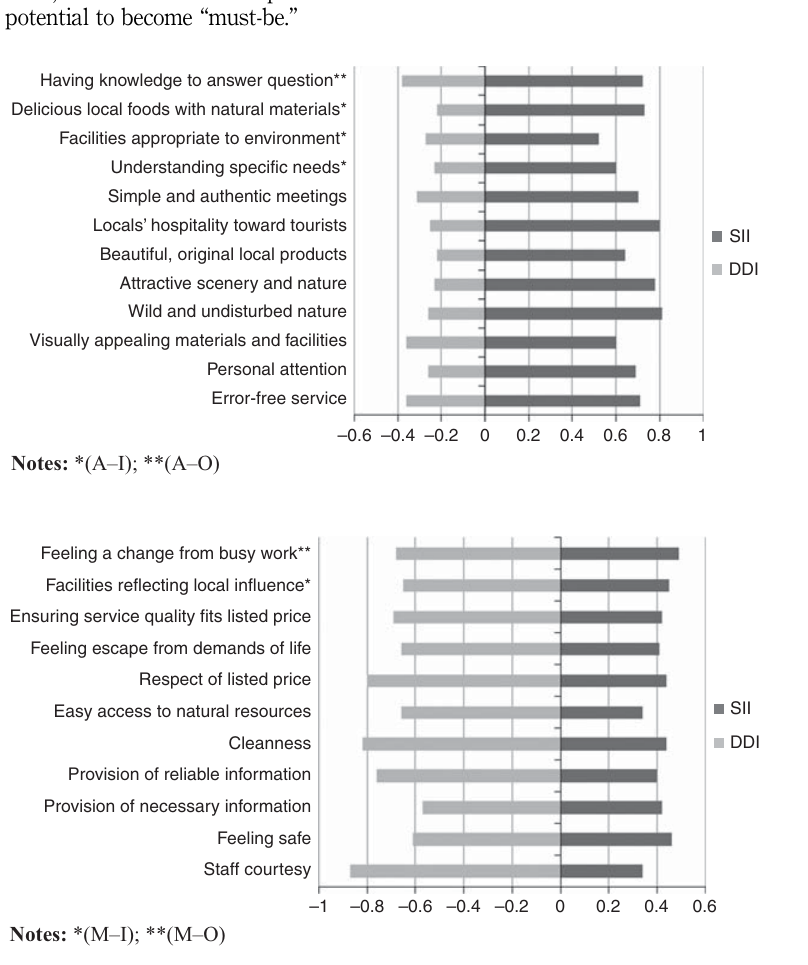
Figure 5. CS Coefficients